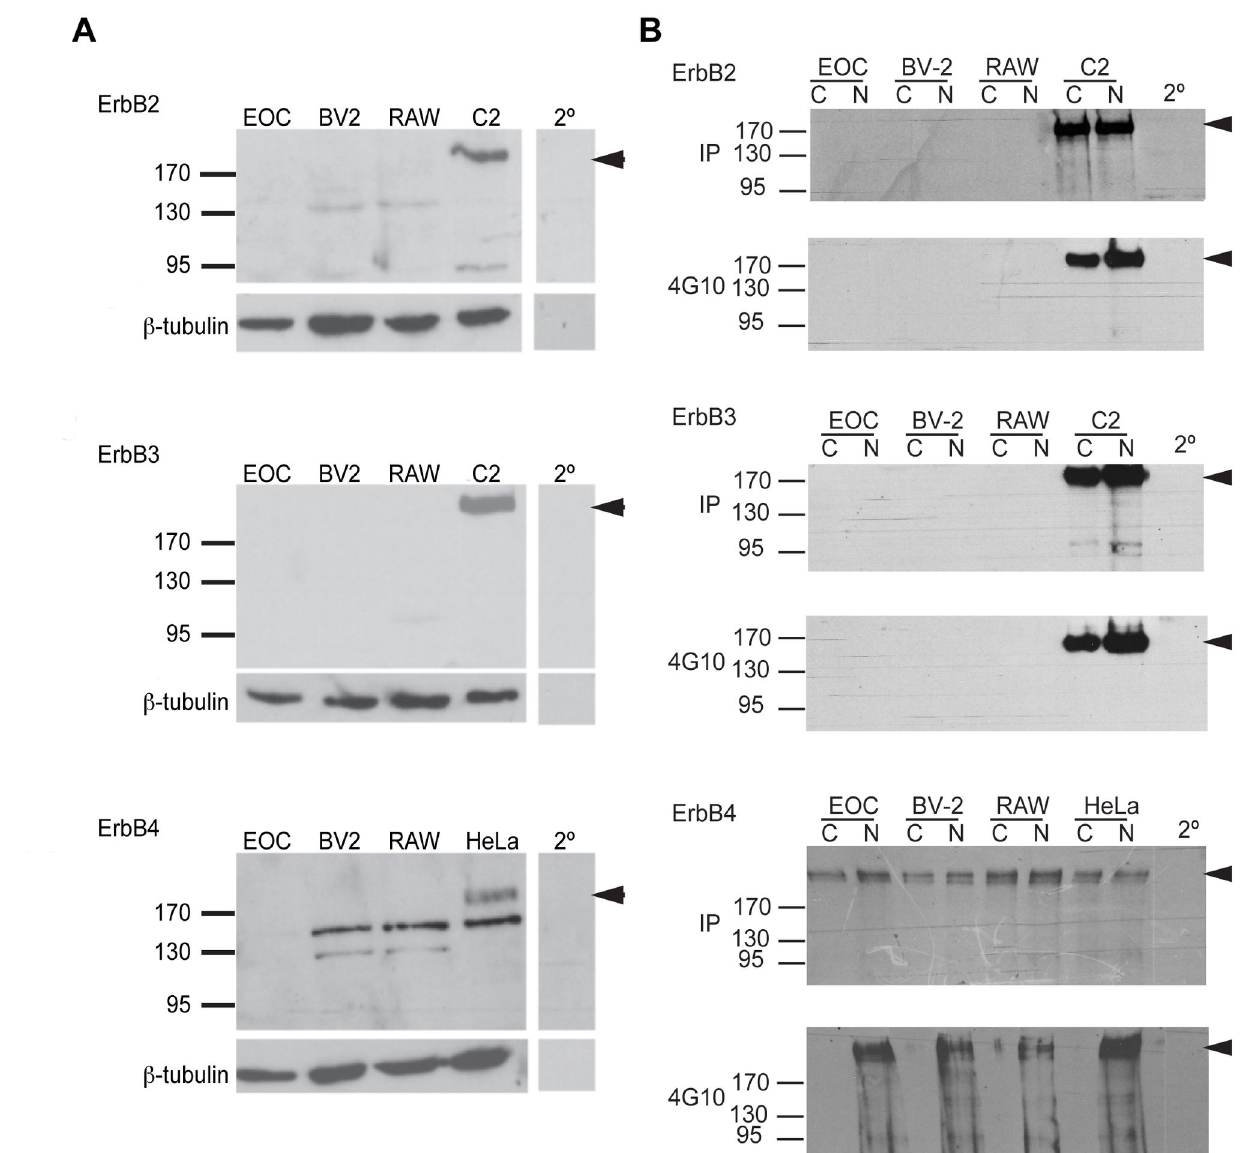
Figure 1. ErbB2-4 receptor expression and phosphotyrosine activity in microglial and macrophage cell lines. Immunoblots of whole cell lysates (panel A) or isolates from immunoprecipitations using anti-ErbB2, anti-ErbB3 and anti-ErbB4 antibodies (panel B) from microglial cell lines (EOC and BV-2) and macrophage (RAW) were probed with antibodies specific for each ErbB receptor. Arrows to the right of each panel indicate the position of each expected immunoreactive species and its mass (185 kDa). Whole lysates from EOC-20, BV-2 and RAW264.7 cell lines immunoblotted with the anti-ErbB2, anti-ErbB3 and anti-ErbB4 antibodies showed no detectable levels of these proteins in each of these cell line (A). However, immunoprecipitated samples from the same cell lines indicate that ErbB4 is expressed (IP, bottom panel B) and that ErbB4 phosphotyrosylation in these cells increased with neuregulin treatment (4G10, bottom panel B). Positive control cell lines were C2C12 for ErbB2 and 3 and HeLa S3 (H) for ErbB4. Secondary controls (shown at right) were probed with secondary antibody only. Mouse anti-β-tubulin antibody indicates equal loading of cell extracts indicated by the band at the bottom of each ErbB panel at 50kDa. Lack of detectable banding in EOC, BV-2 and RAW may indicate no or low levels of the ErbB receptors. doi: 10.1371/journal.pone.0070338.g001 It was the addition of ACh that produced a dramatic decease in TNF-α in cells also treated with NRG and LPS. ELISA analysis